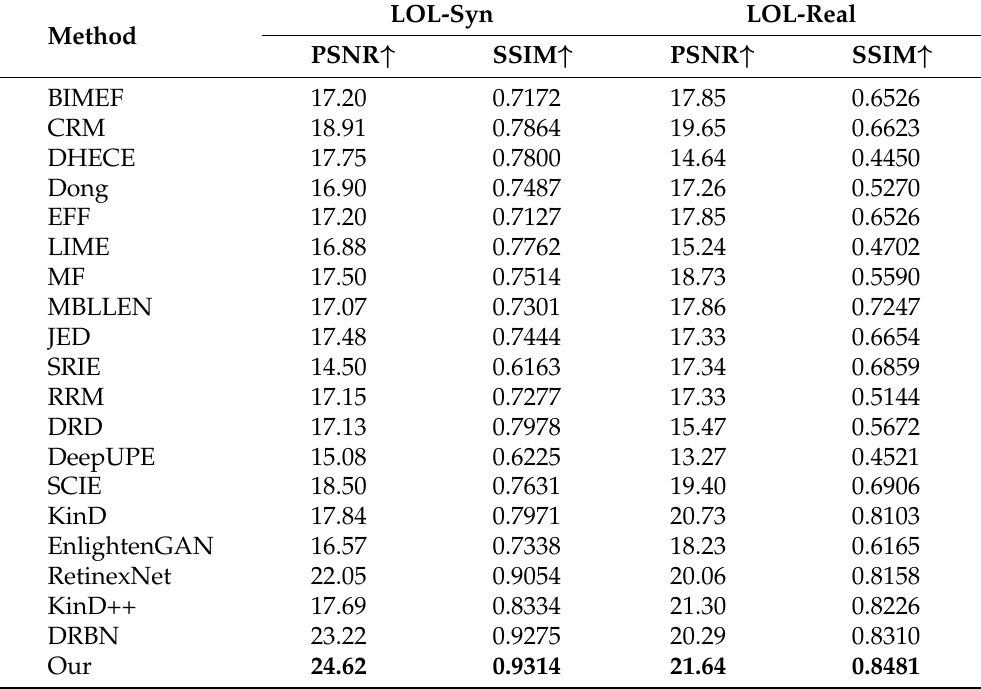
Table 1. Quantitative evaluation on LOL synthetic and real dataset, in terms of PSNR and SSIM. The best results are in